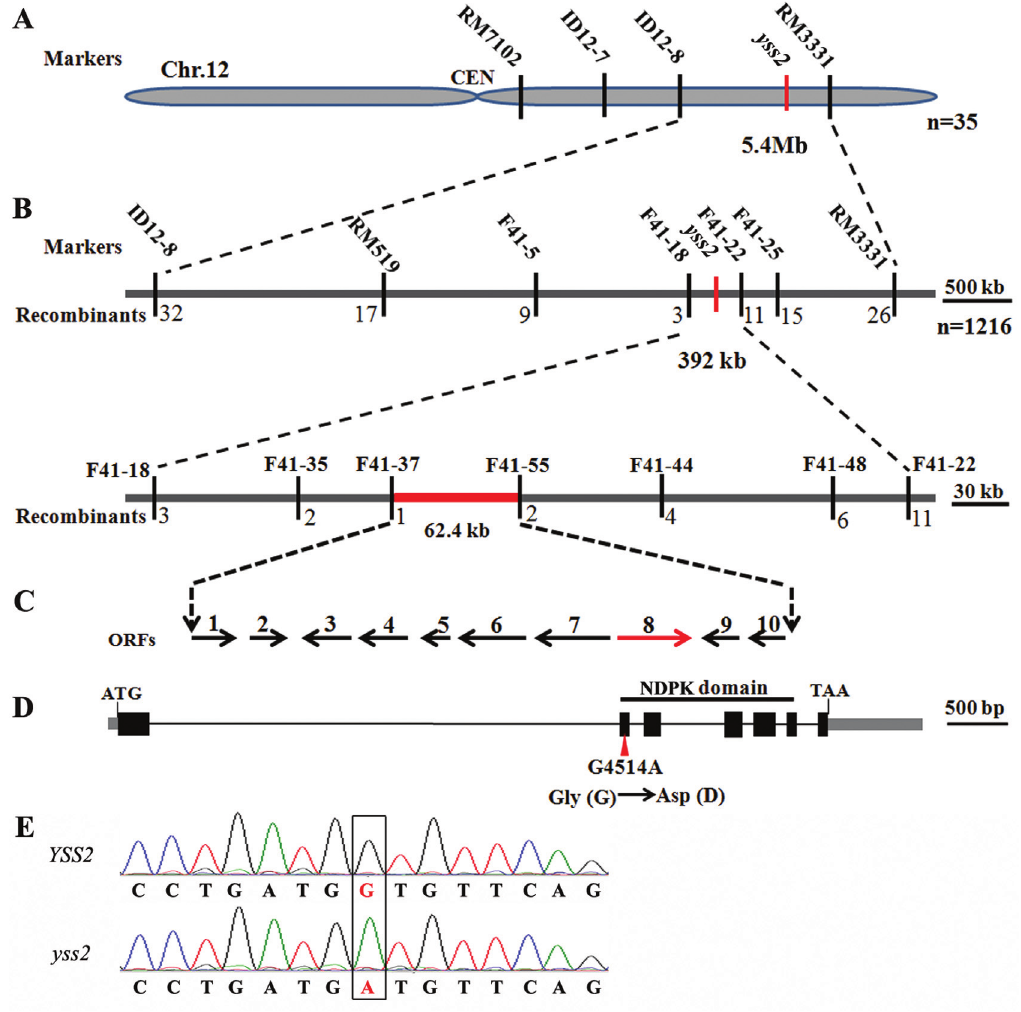
Figure 2 - Positional cloning of the YSS2 gene. (A) The yss2 locus was mapped to a 5.4 Mb region between Indel/SSR markers ID12-8 and RM3331 on chromosome 12L. (B) The yss2 locus was narrowed to a 62.4 kb interval between Indel markers F41-37 and F41-55 using 1,216 F 2 homozygous mutant plants. (C) Ten ORFs were predicted in the region. (D) Schematic of ORF8 structure. ATG and TAA represent the start and stop codons, respectively. Gray boxes indicate 5’ and 3’ UTR. Black boxes and lines between them separately indicate exons and introns. The NDPK domain is indicated. The yss2 mutant has a single G to D change in the eighth ORF. The mutation site is indicated by a red arrowhead. The single nucleotide change led to a Gly (G) to Asp (D) substitution. (E) Chromatograms from sequencing of wild type and yss2 genomic DNA. Black frame indicates the mutation site